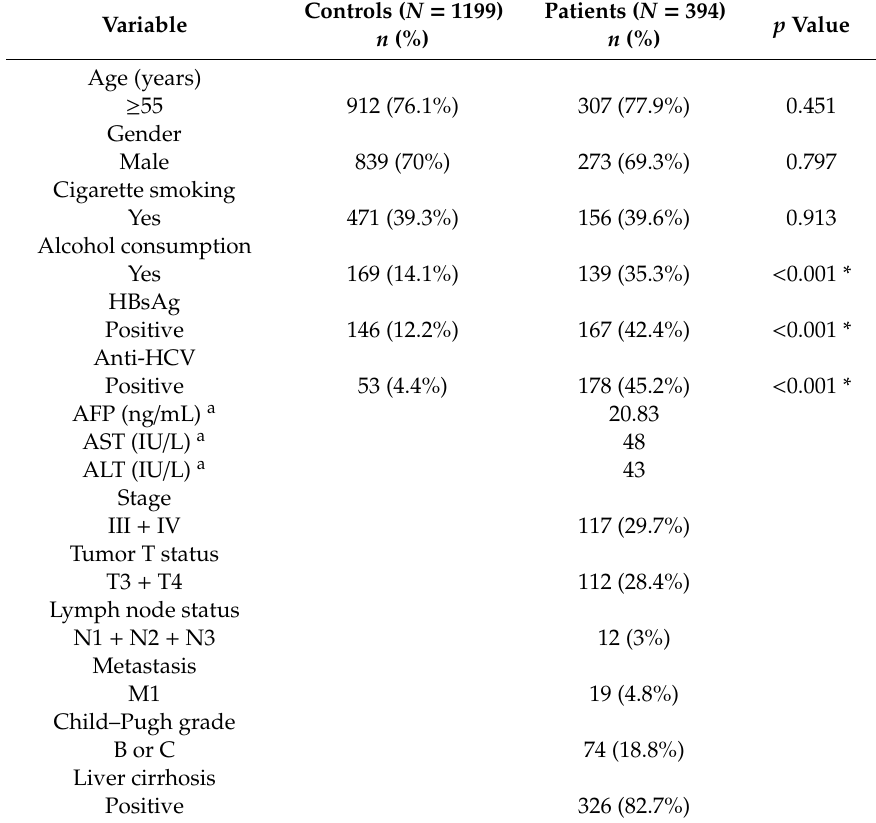
Table1. Distributionsofdemographiccharacteristicsin1199controlsand394patientswithhepatocellular carcinoma.